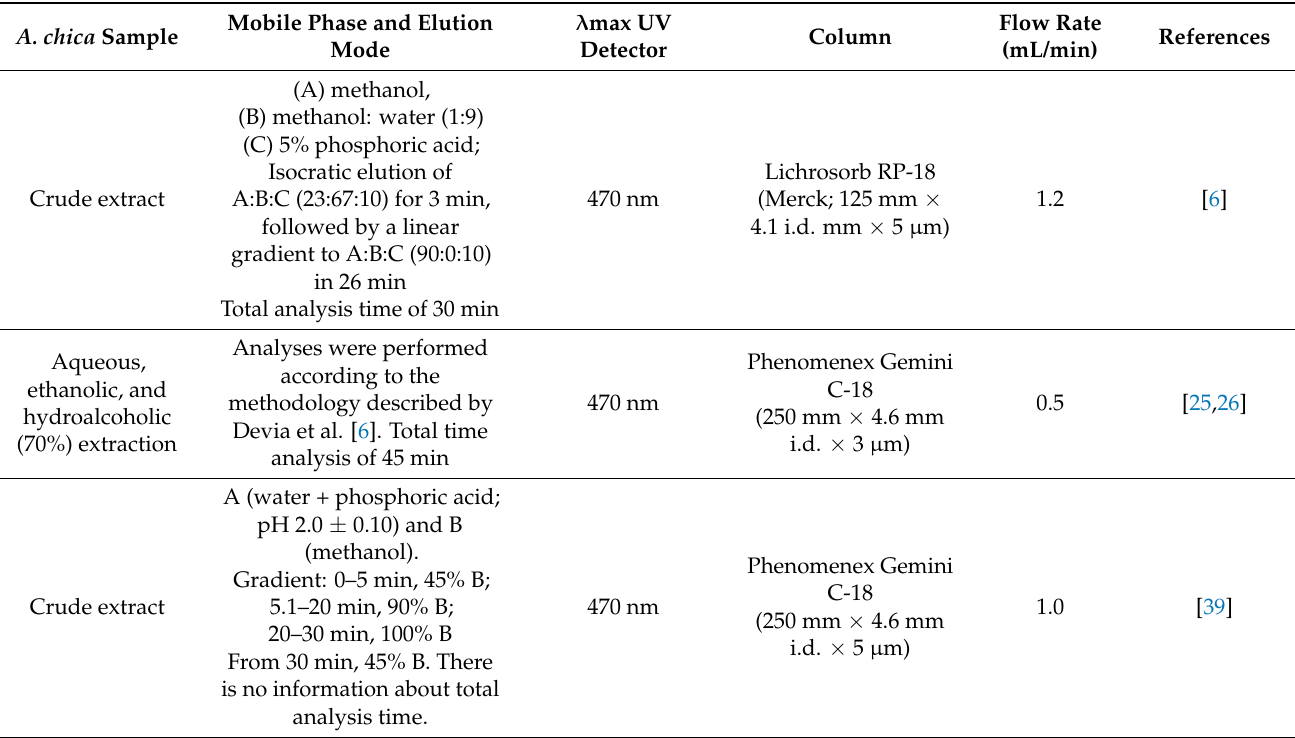
Table 8. HPLC-DAD methods from the literature to analyze anthocyanidins in Arrabidaea chica